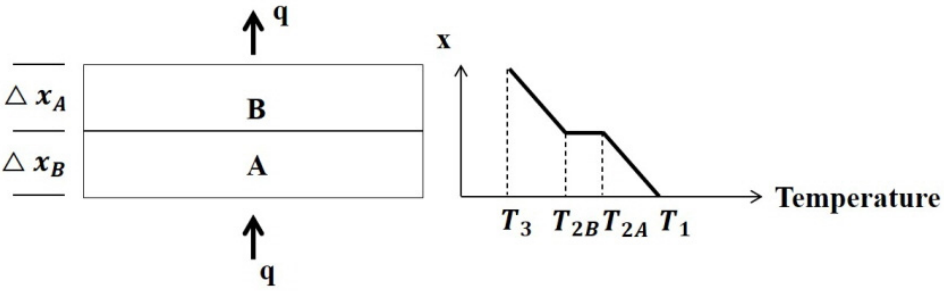
Figure 3. Diagram of thermal contact conductance.